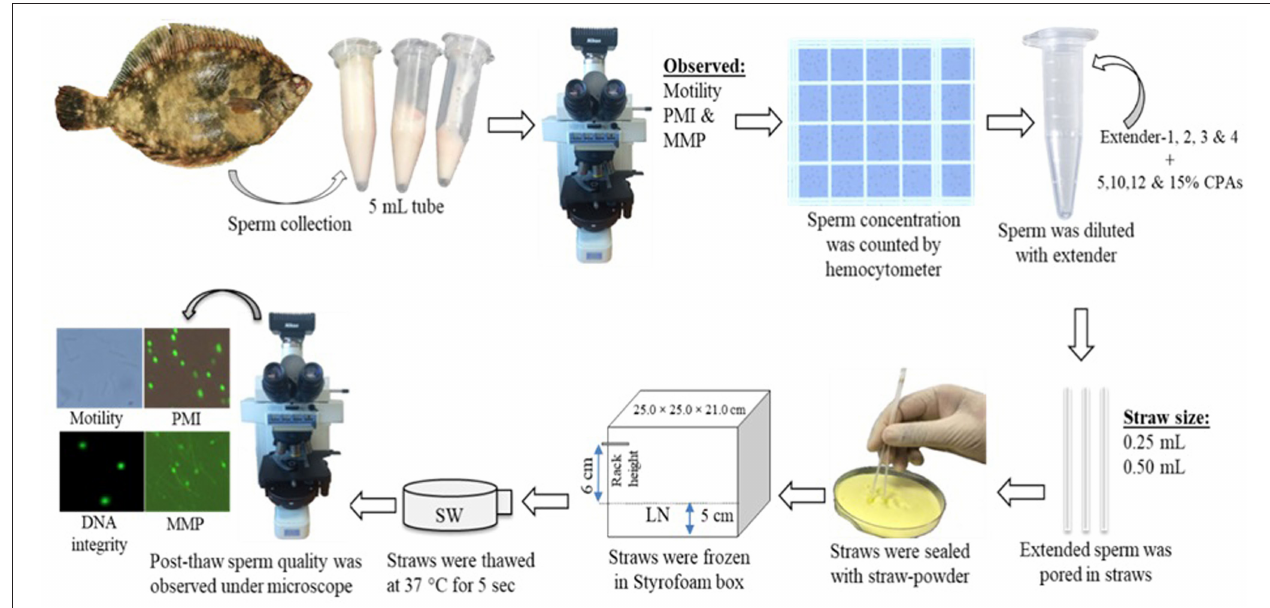
FIGURE 1 | Flow diagram showing the cryopreservation technique used for marbled flounder sperm.